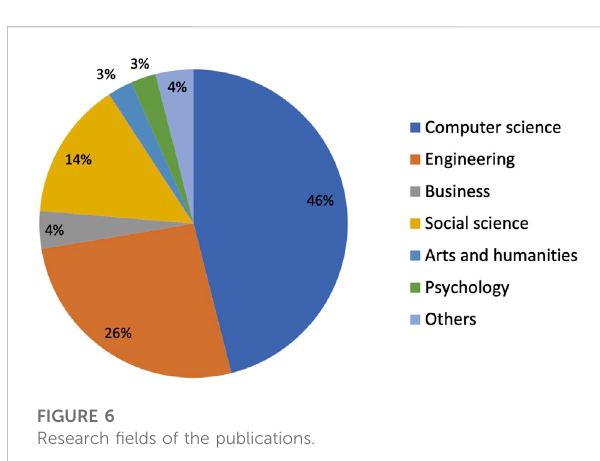
FIGURE 6 Research fi elds of the